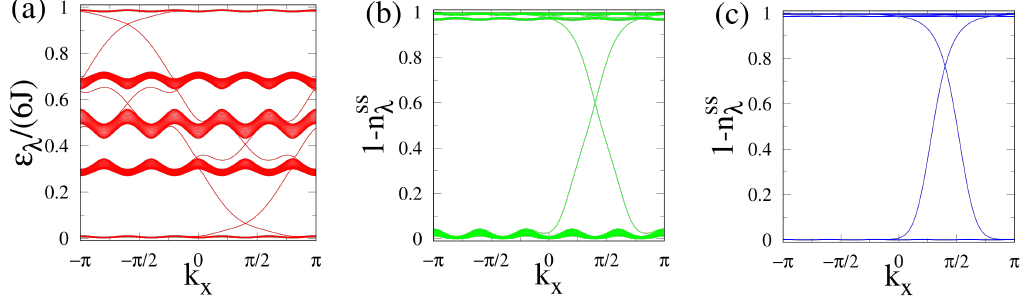
Figure 3: (a) The eigenenergies of the Hofstadter reference Hamiltonian (13) with periodic boundary conditions in the x direction (that is, on a cylinder whose axis is = 2.93 J (set to bring the minimal energy to in the y direction) for α = 1 / 5 and J 0 zero). In between the q = 5 bands there are chiral midgap edge modes localized at the two ends of the system. (b) The spectrum of the steady state single-particle reduced density matrix, Eq. (9) [ 1 − n ss is plotted so that the order of states is as in (a) ] λ J 2 . The four resulting from the Lindblad dynamics, Eq. (7)–(8), with γ in = 0.2 πν 0 upper bands appear together at the top, but are actually separated by small gaps. (c) The same with the reference Hamiltonian (13) containing the next-nearest-neighbor hopping terms of the Kapit-Mueller Hamiltonian [ 70 ]